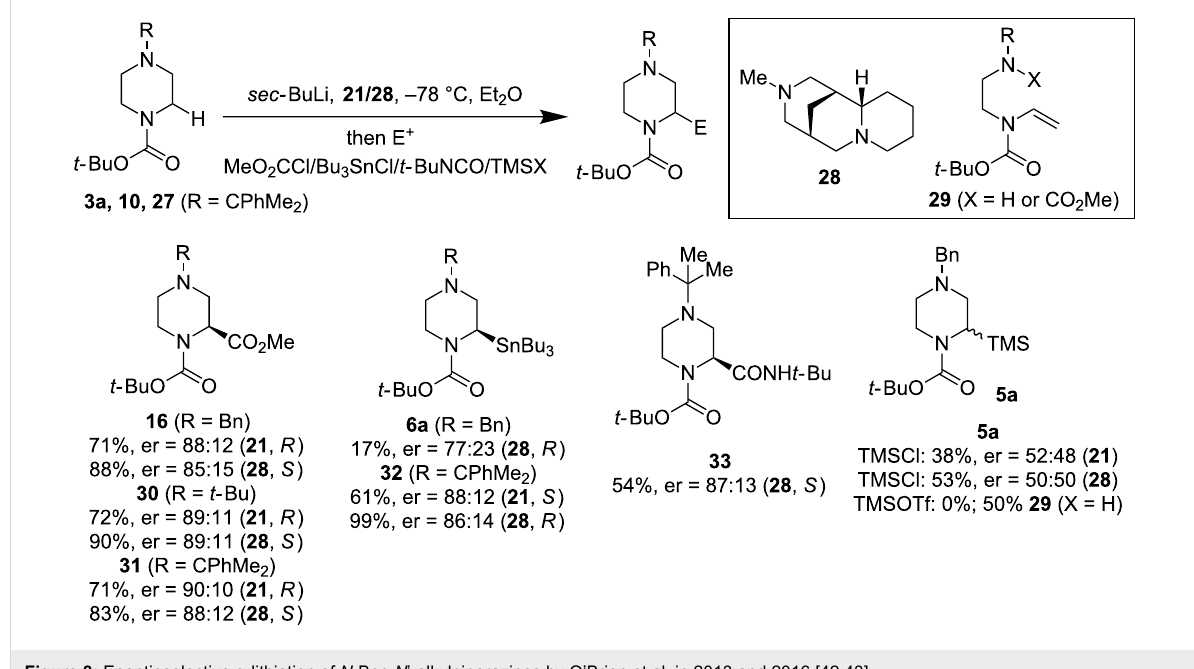
Figure 8: Enantioselective α -lithiation of N -Boc- N ’-alkylpiperazines by O’Brien et al. in 2013 and 2016 [42,43].